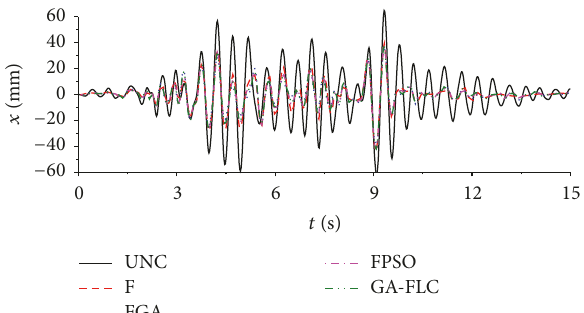
Figure 17: Top-layer displacement response curve under the action of the Nanjing wave.